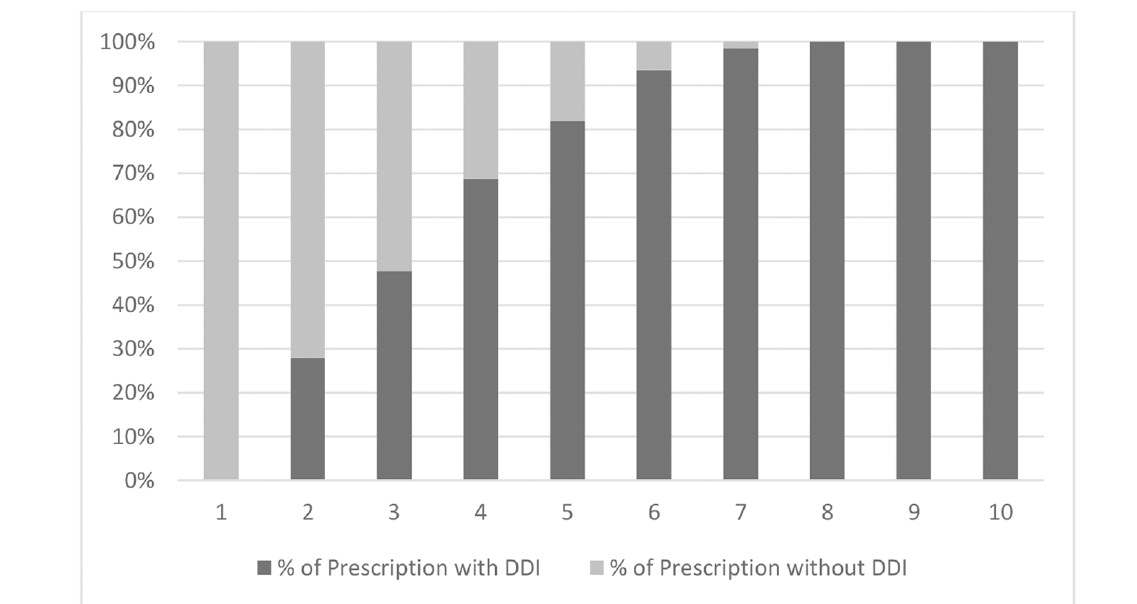
FIGURE 2 – Percentage of clinically relevant Drug- Drug Interaction in prescriptions based on the number of items in